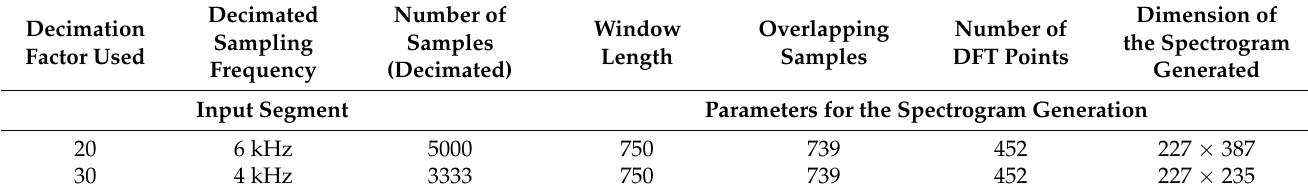
Table 6. Parameters chosen and size of the spectrogram images generated.